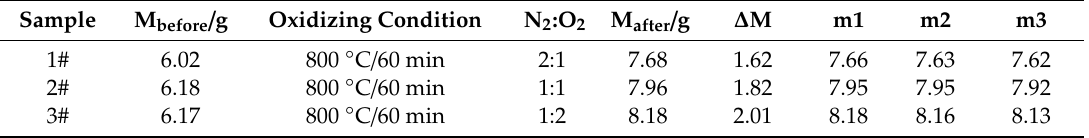
Table 1. Quality change of the TiO 2 / Ti composite membrane before and after ultrasonic cleaning.